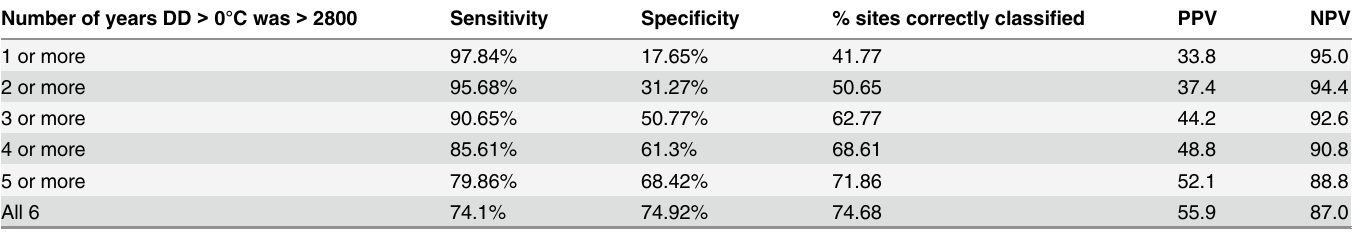
Table 4. Results of ROC analysis of the sensitivity and specificity of the number of years from 2009 – 2014 in which DD > 0°C was > 2800 for predict- ing the presence of I . scapularis -positive sites in Québec, Nova Scotia and New Brunswick using surveillance data collected in this and in previous